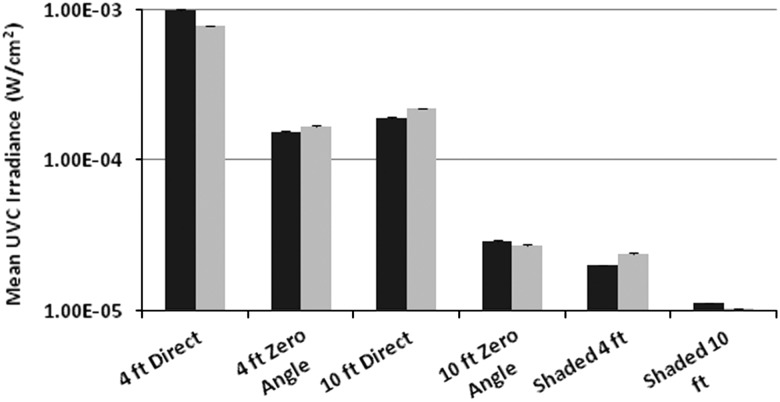
Mean ultraviolet C (UV-C) and standard deviation (SD) irradiance levels (W/cm
2
) measured with 6 UV-C sensors placed at different distances and orientations relative to a mobile UV-C device in an intensive care unit room (left column at each position) and a room on a surgical ward (right columns). Sensor positions included in direct sight at distances of 1.3 m (4 ft) and 3.3 m (10 ft), at a 0° angle relative to the device at distances of 1.3 m and 3.3 m, and in shaded areas 1.3 m and 3.3 m from the device.